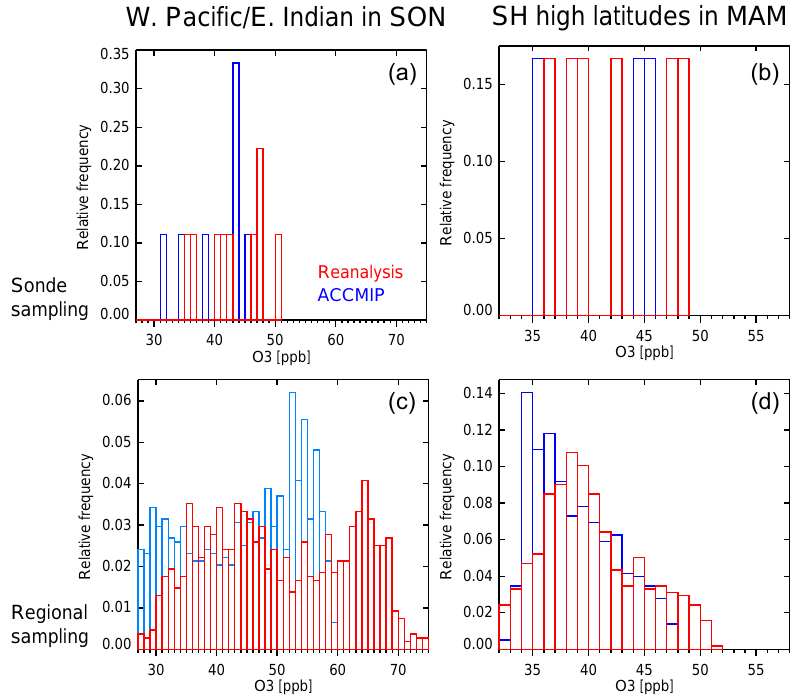
Figure 10. Probability distribution functions (PDFs) of ozone concentration obtained from the ACCMIP multi-model mean (blue) and the reanalysis (red) at 500hPa for W. Pacific/E. Indian in SON (a, c) and for the SH high latitudes in MAM (b, d) . The plots are shown for all model and reanalysis grid point (c, d) and for the ozonesonde sampling (a, b) within each defined region.